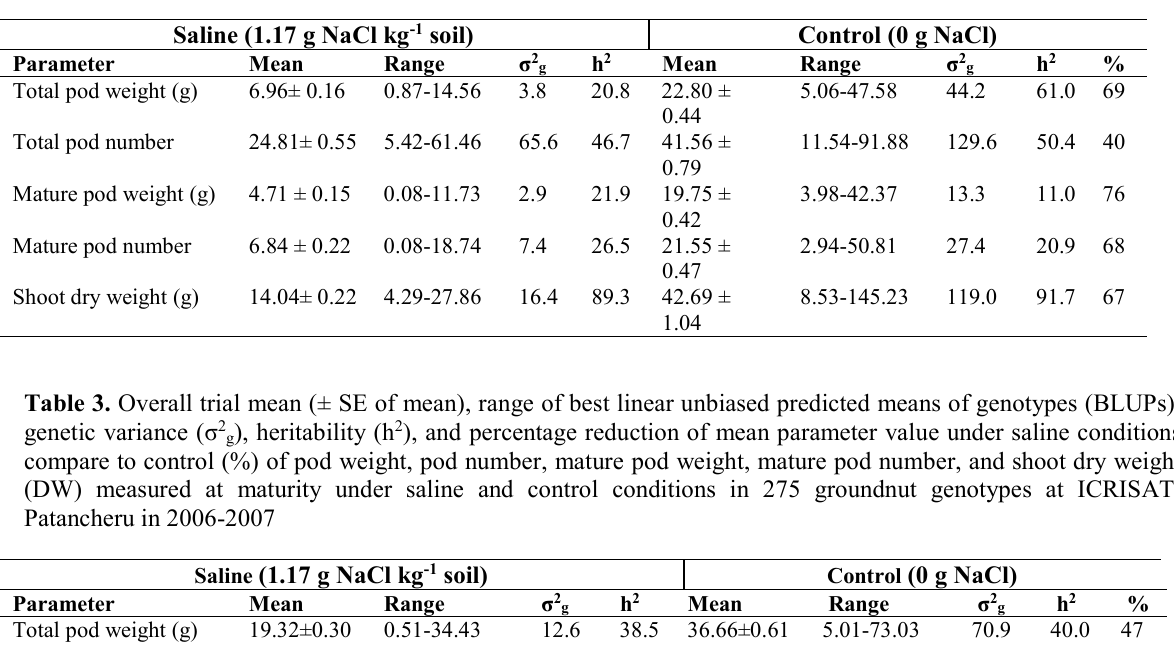
Table 2. Overall trial mean, range of best linear unbiased predicted means of genotypes (BLUPs), genetic variance (σ 2 g ), heritability (h 2 ), and percentage reduction of mean parameter value under saline conditions compare to control (%) of pod weight, pod number, mature pod weight, mature pod number, and shoot dry weight (DW) measured at maturity under saline and control conditions in 275 groundnut genotypes at ICRISAT, Patancheru, 2006.